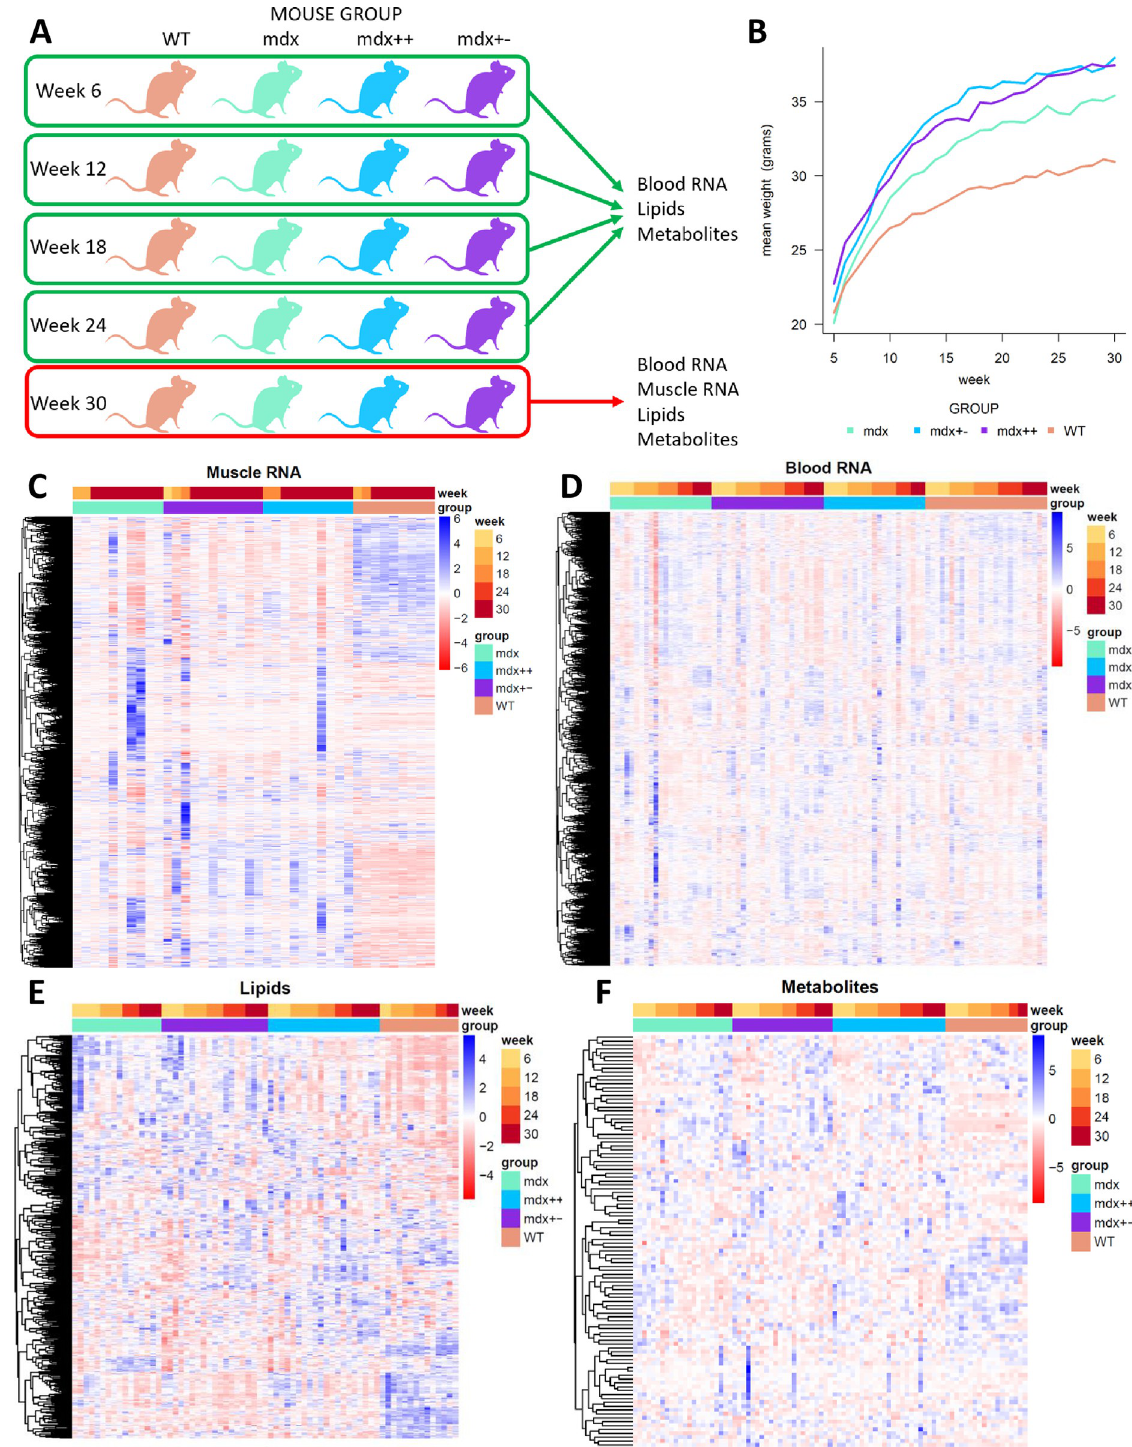
Fig 1. Overview of the multiomic data analysed in this article. A) Schematic representation of the experiment. WT, mdx , mdx ++ and mdx +- mice were monitored for 30 weeks. Blood samples were drawn every 6 weeks, allowing measurement of RNA, lipids and metabolites. At week 30, mice were sacrificed and muscle samples drawn, allowing measurement of RNA expression in muscle. B) Weekly mean weight (in grams) of the mouse groups, measured from week 5 to week 30. C-F) Heatmaps showing the distribution of blood RNA (panel C), muscle RNA (panel D), lipids (panel E) and metabolites (panel F) across samples.